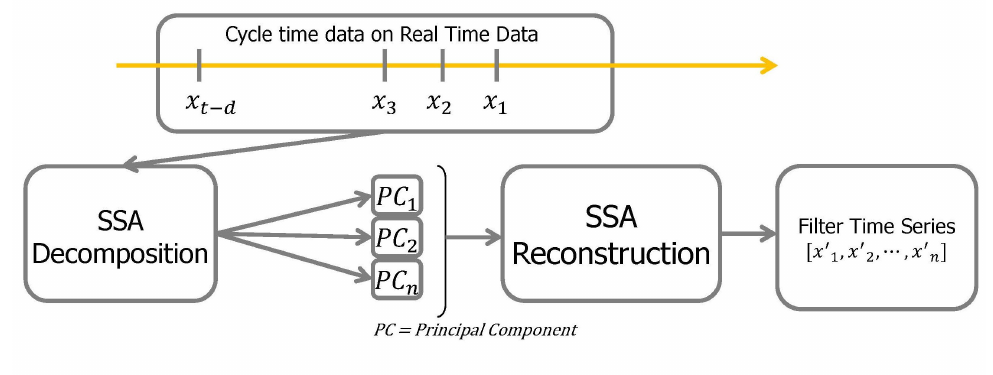
Figure 2. Basic Architecture Singular Spectrum